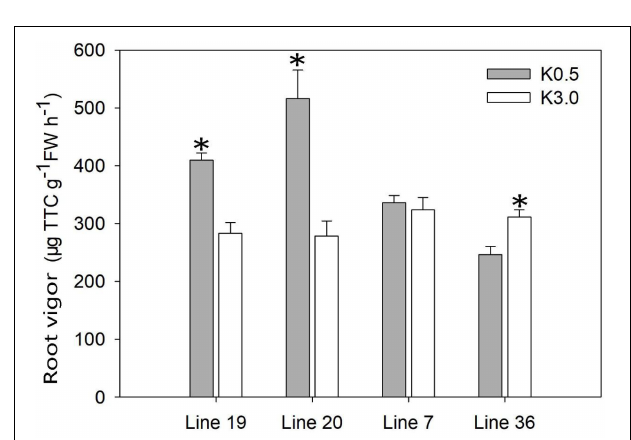
FIGURE 3 | Effect of low K treatment on root vigor of vegetable soybean with different K efficiency in a hydroponic experiment. Values are means of three replicates ± SE. ∗ means significant differences at P < 0.05